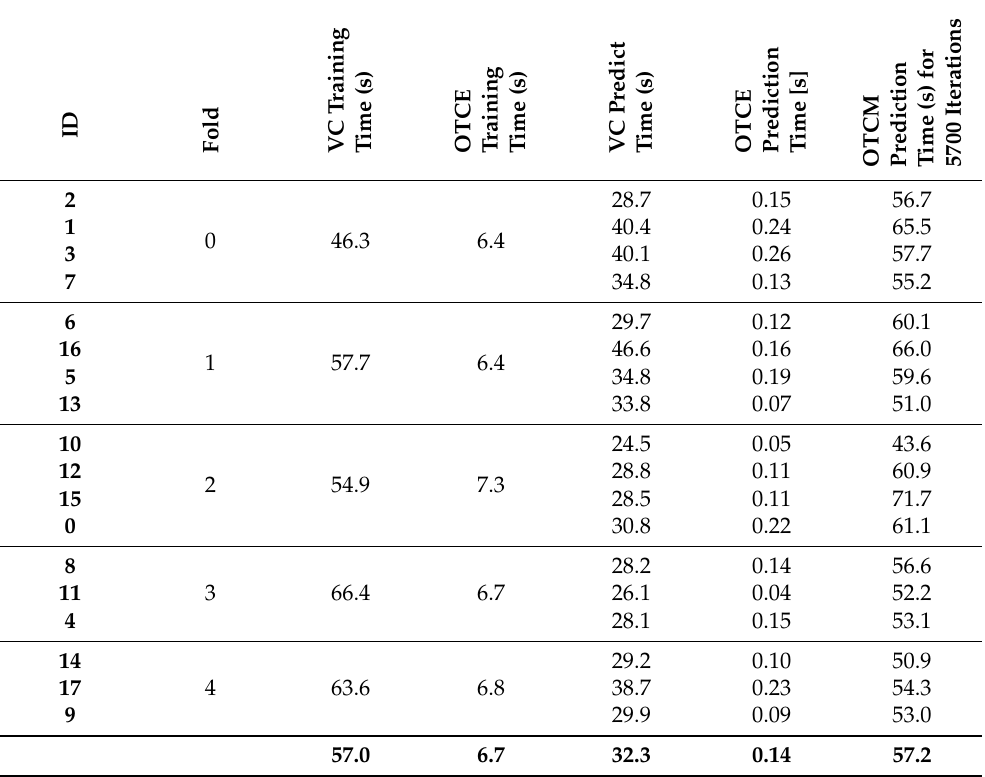
Table 4. Execution times of each model block. A training time for each fold and the prediction times for each capture ID are shown. The last row shows the mean of each